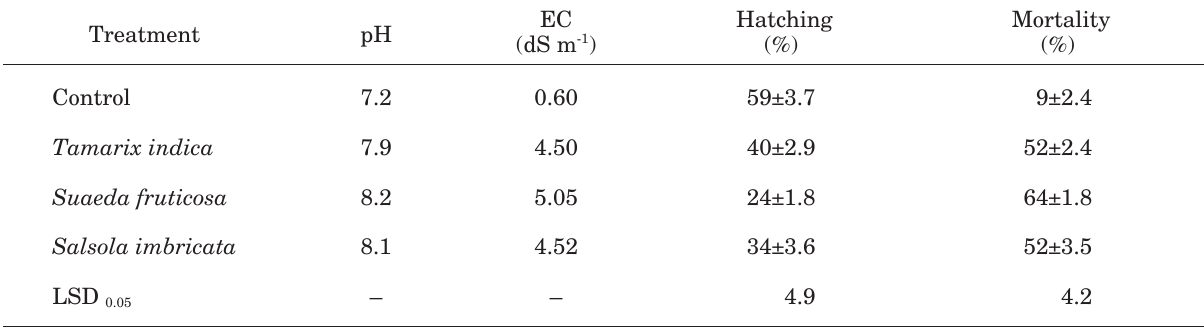
Table 1. Effect of three halophytes (2.5%) on hatching and mortality of Meloidogyne javanica second-stage juveniles.